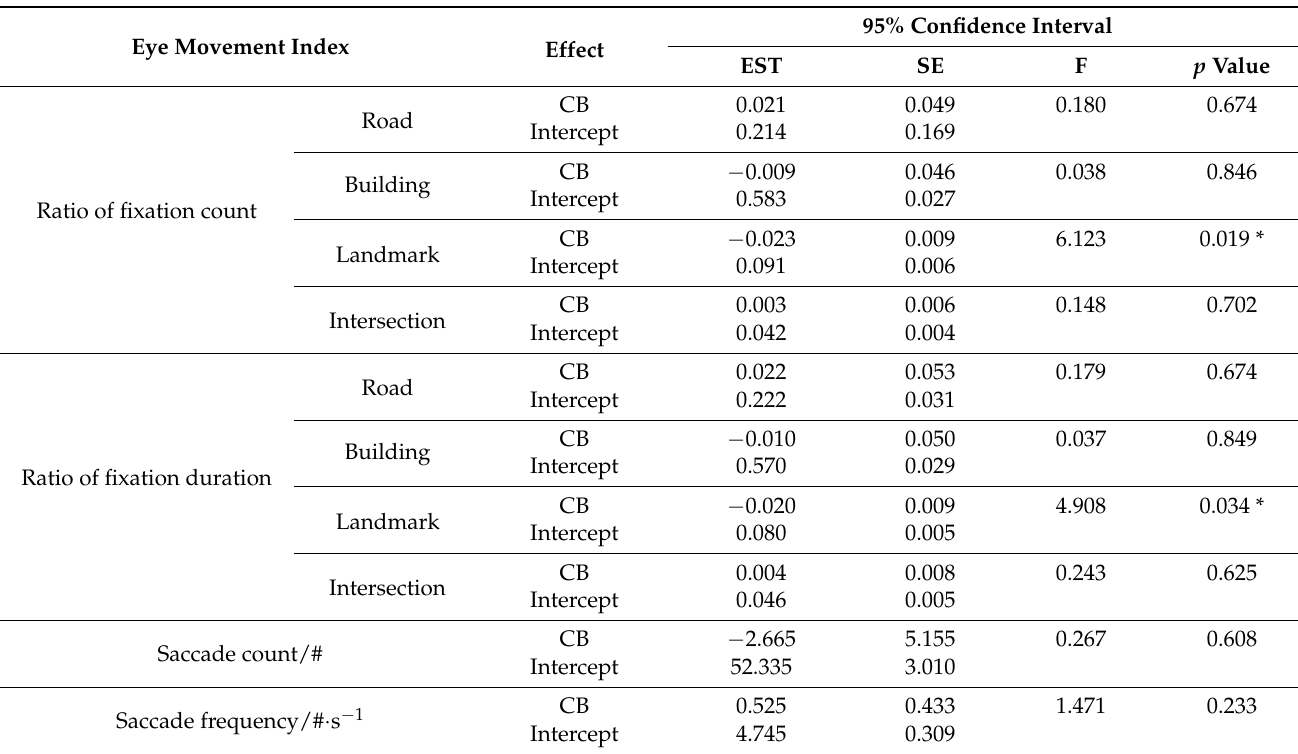
Table A3. Linear mixed model regression results of eye movement data in the spatial orientation task (CB, cultural background; SE, standard error; EST, estimate; * p < 0.05, ** p <